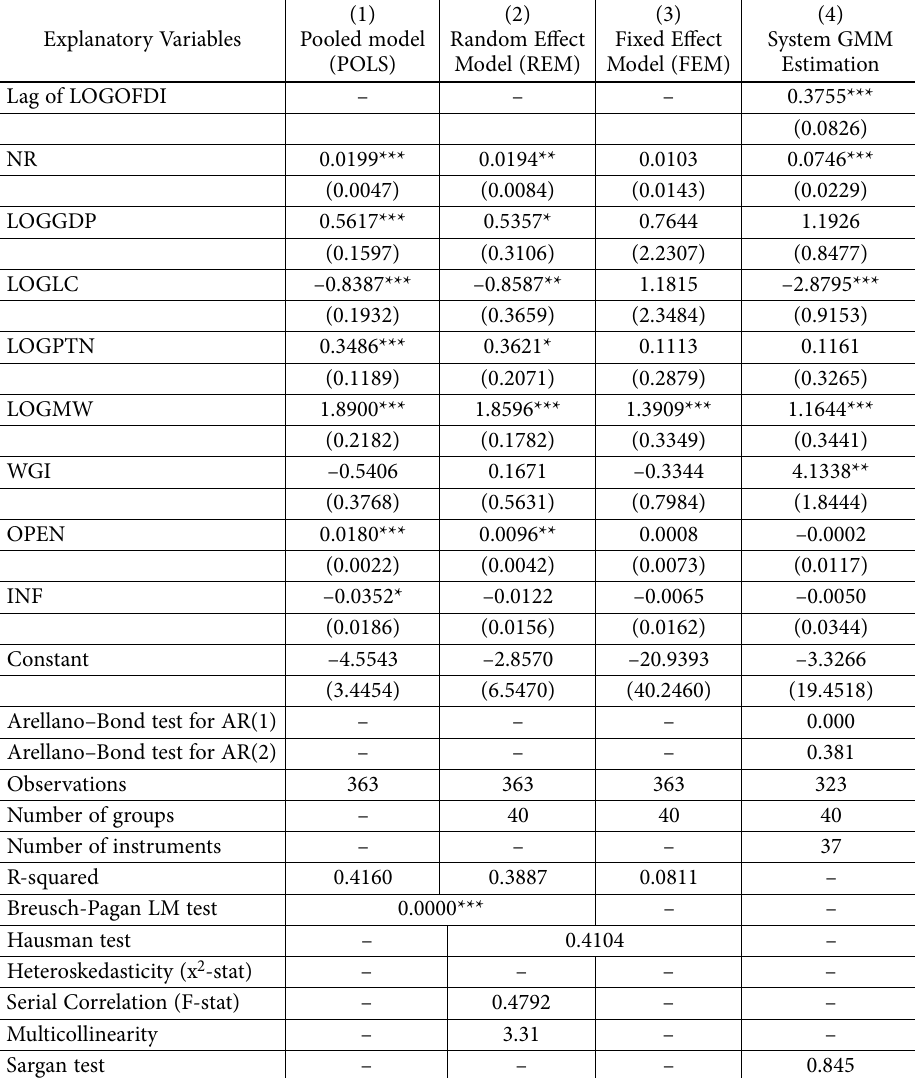
Table 2. The determinants of China Outward Direct Investment (COFDI) using Augmented Dunning Model (whole sample) Explanatory